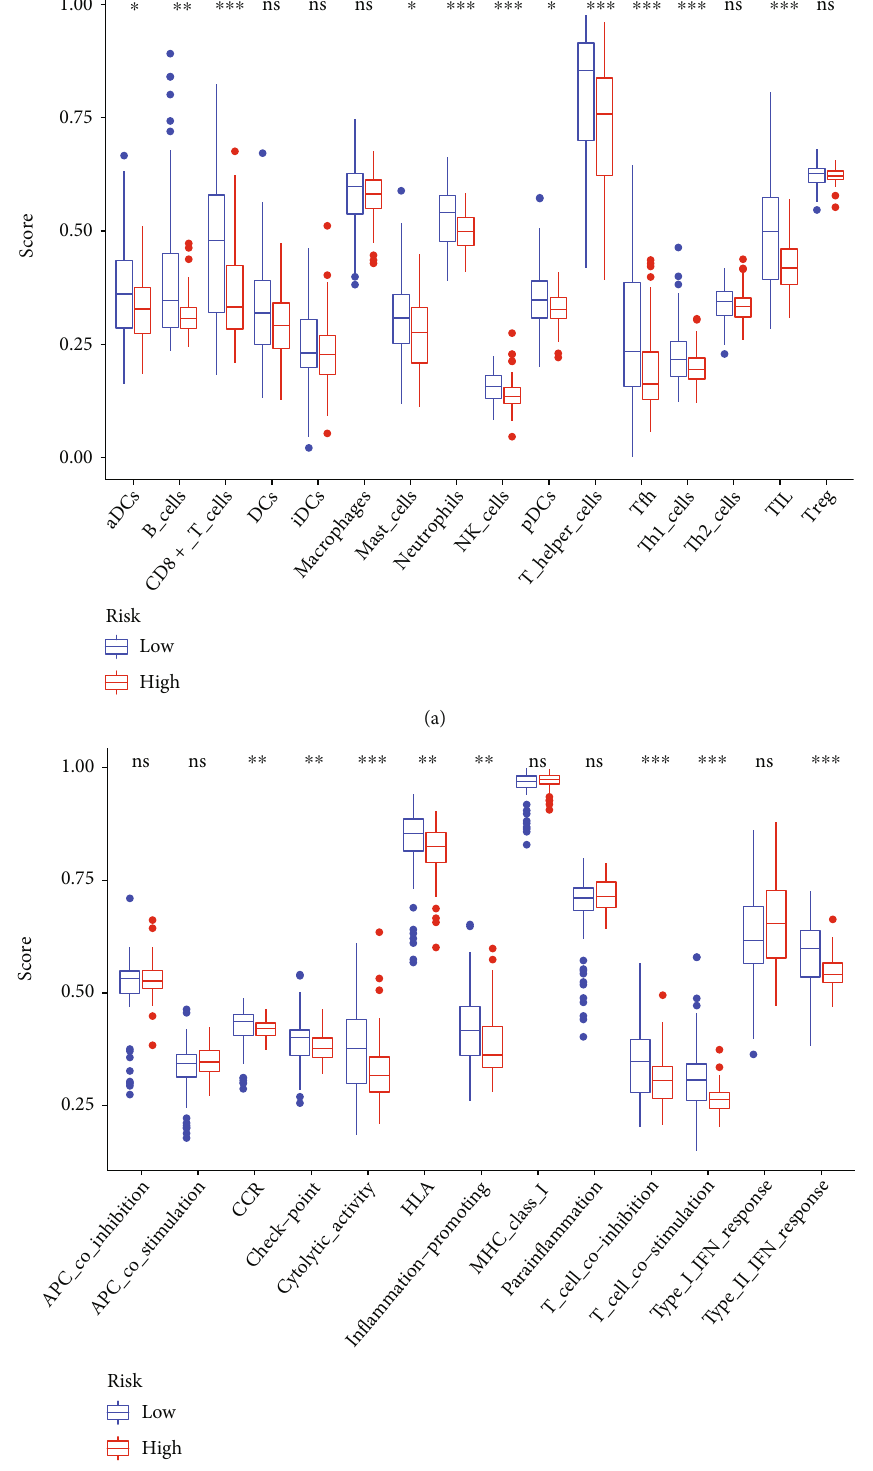
Figure 7: The relationships between risk score and tumor microenvironment. (a) The scores of 16 immune cells. (b) Boxplots were used to illustrate 13 immune-related